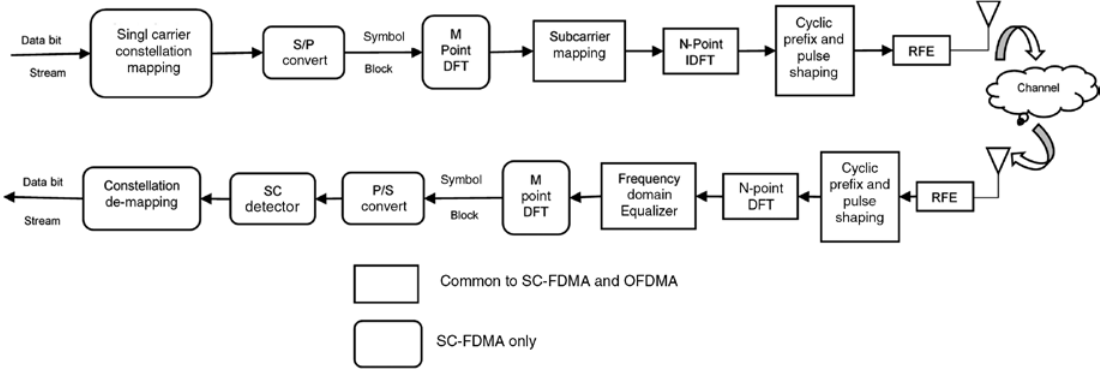
Figure 2: Functional Commonality of SC-FDMA and